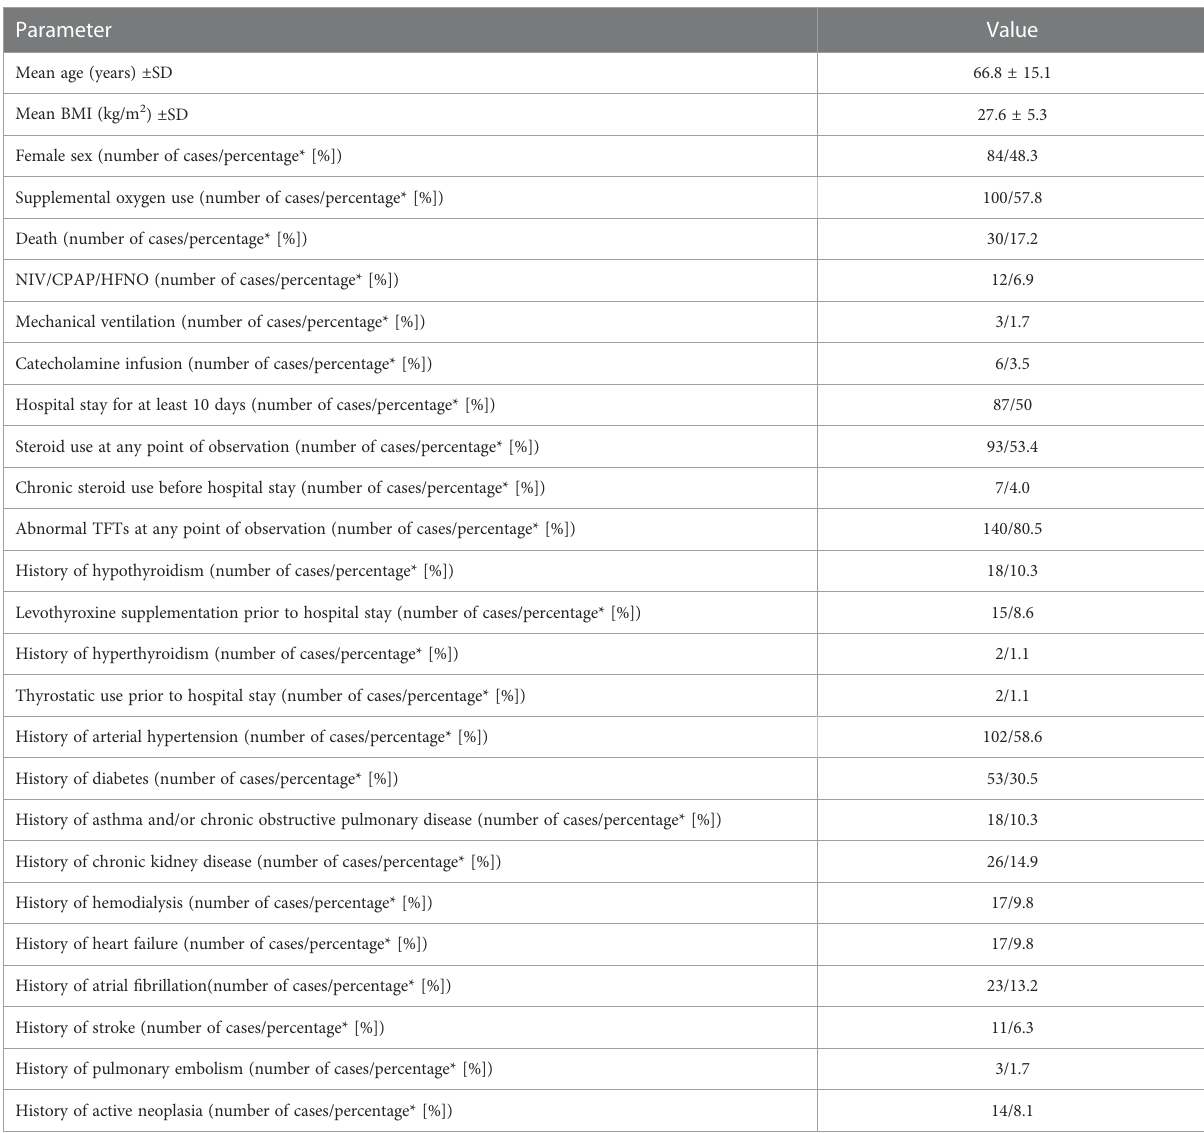
TABLE 1 General characteristics at